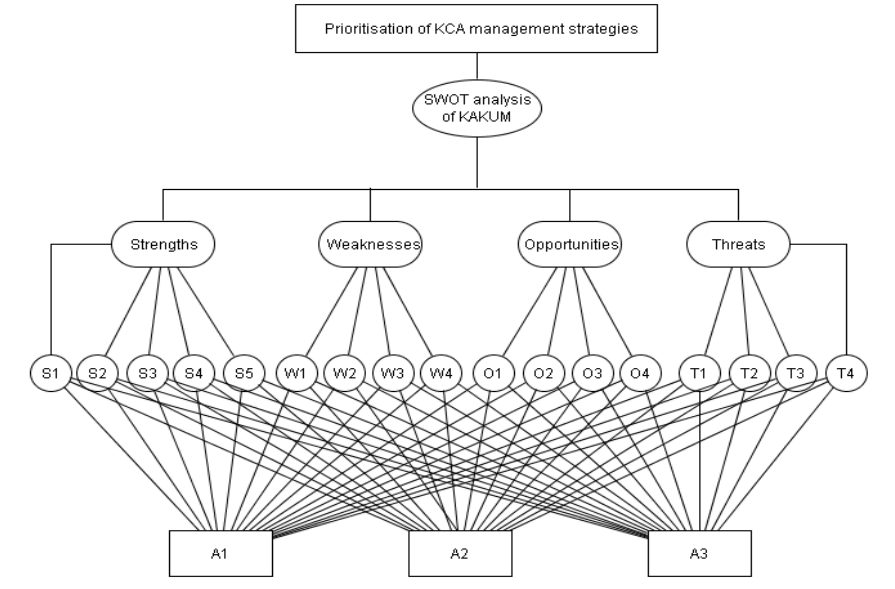
Fig. 1. Hierarchical SWOT-AHP